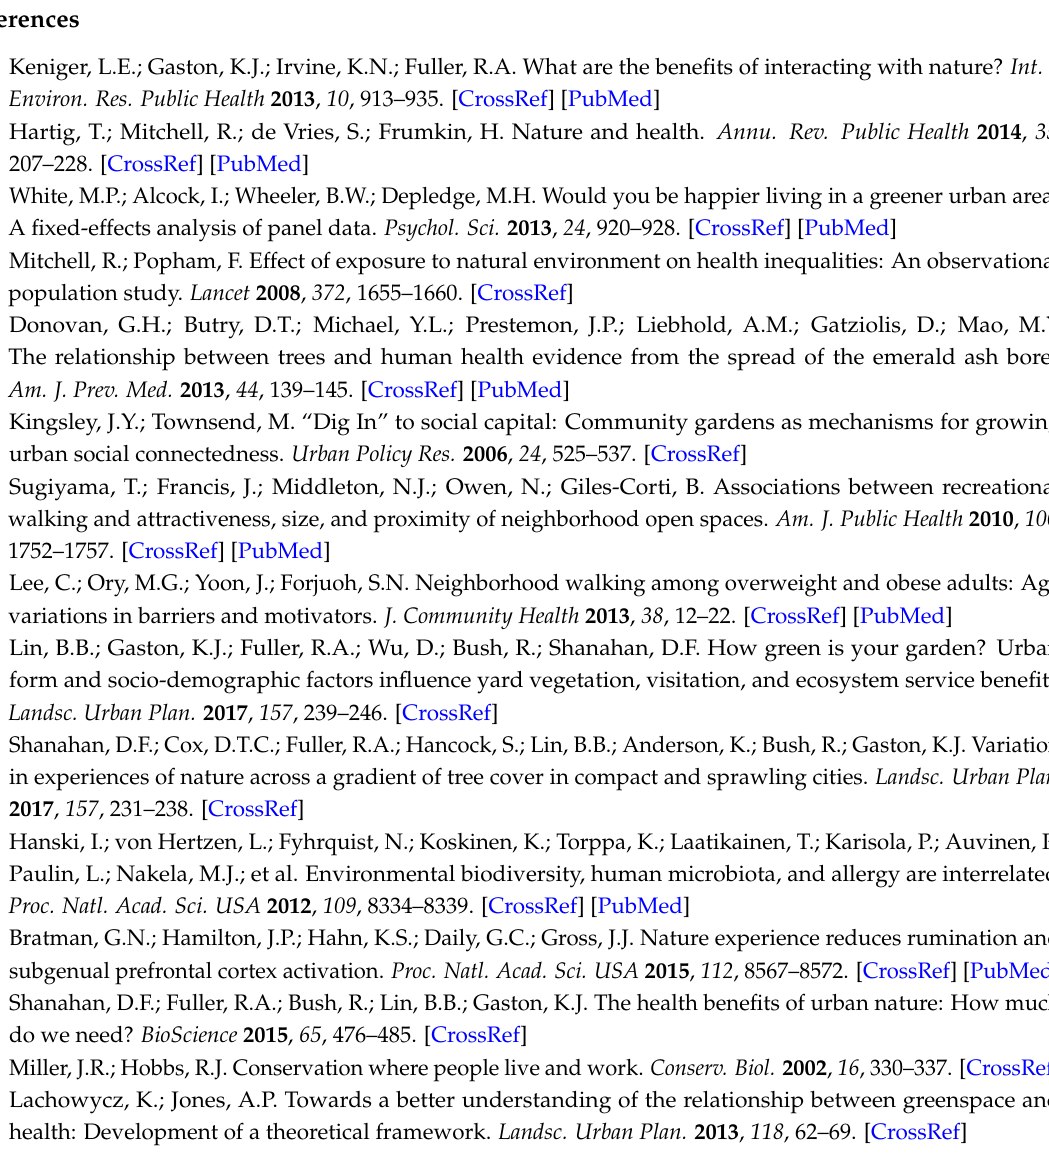
Table S4: Binary risk factors for each covariate. For those predictor variables that were statistically significant in Table 1, we transformed each into a binary risk factor conveying “high” (1) versus “low” (0) risk. We used existing evidence where possible. We also transformed each of the nature dose variables into binary risk factors by setting incrementally higher thresholds of